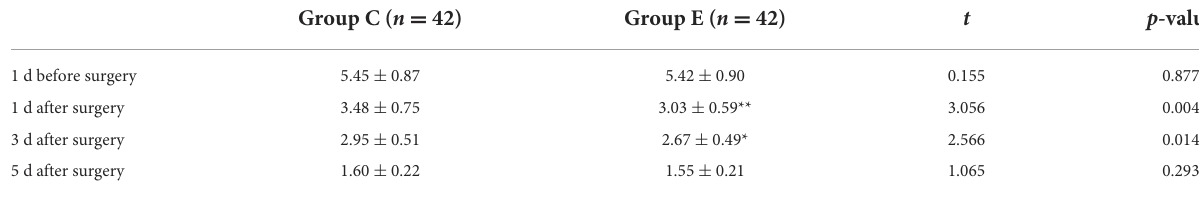
TABLE 3 Comparison of VAS of the two groups.